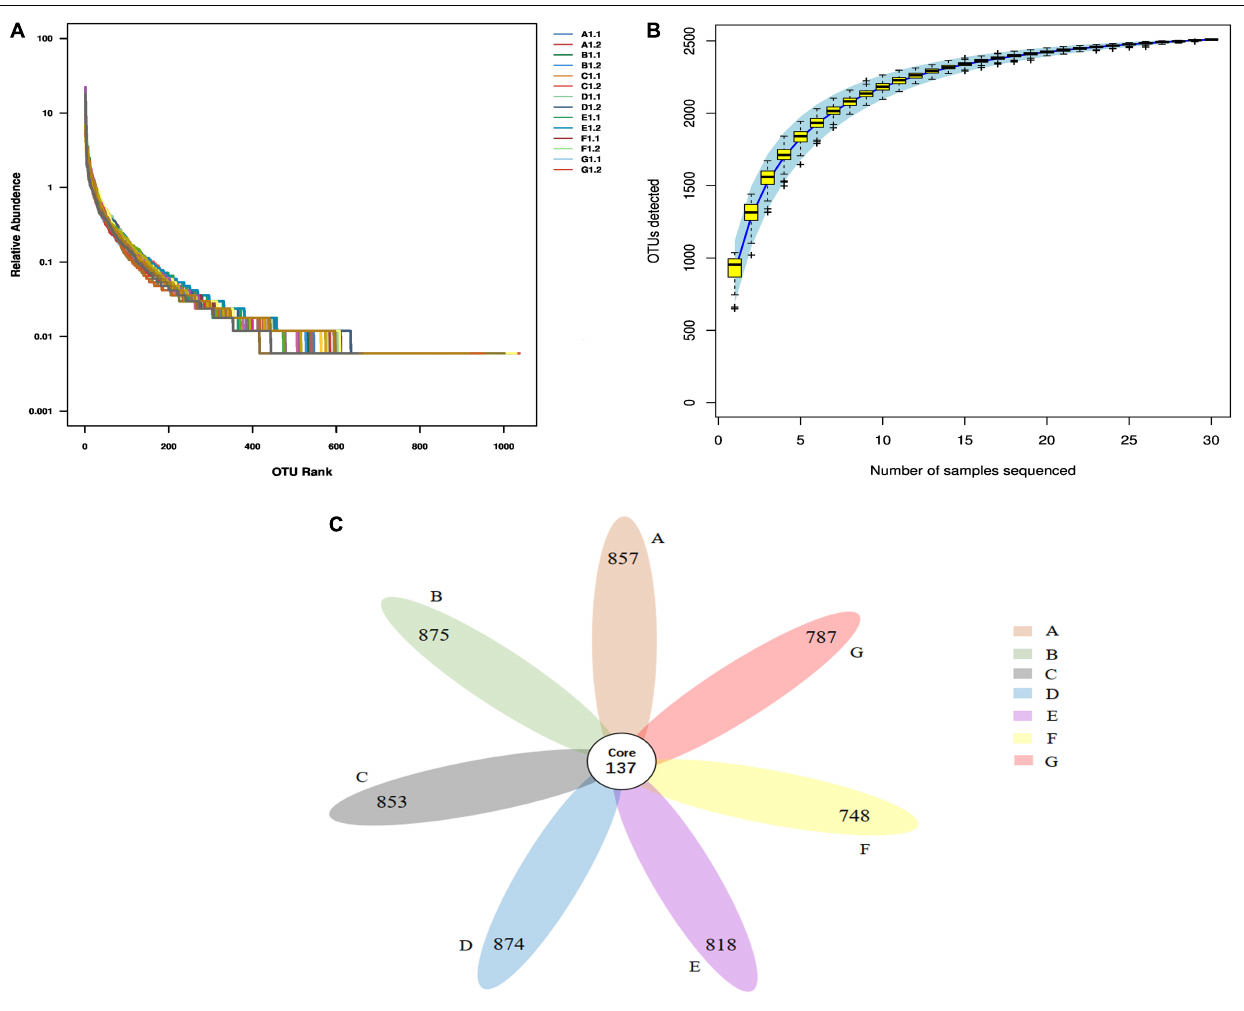
FIGURE 6 | Biodiversity measures of the intestinal microbiota in all of the mice samples. (A) OTU rank curve, (B) OTU cumulative curve, and (C) Petal map of fecal samples in each group. In the petal chart, each petal represents a group, the core number in the middle represents the number of OTUs common to all samples, and the number on the petal represents the number of OTUs unique to the sample. (A: Middle-dosage of FPEP, B: High-dosage of FPEP, C: Middle-dosage of FPEPH, D: High-dosage of FPEPH, E: SSM, F: MC, G: NC). NC: control group; MC: model group; SSM: sour soybean milk; FPEP: fermented with P. eryngii polypeptides with a molecular weight of < 3 kDa; FPEPH: fermented with P. eryngii protein